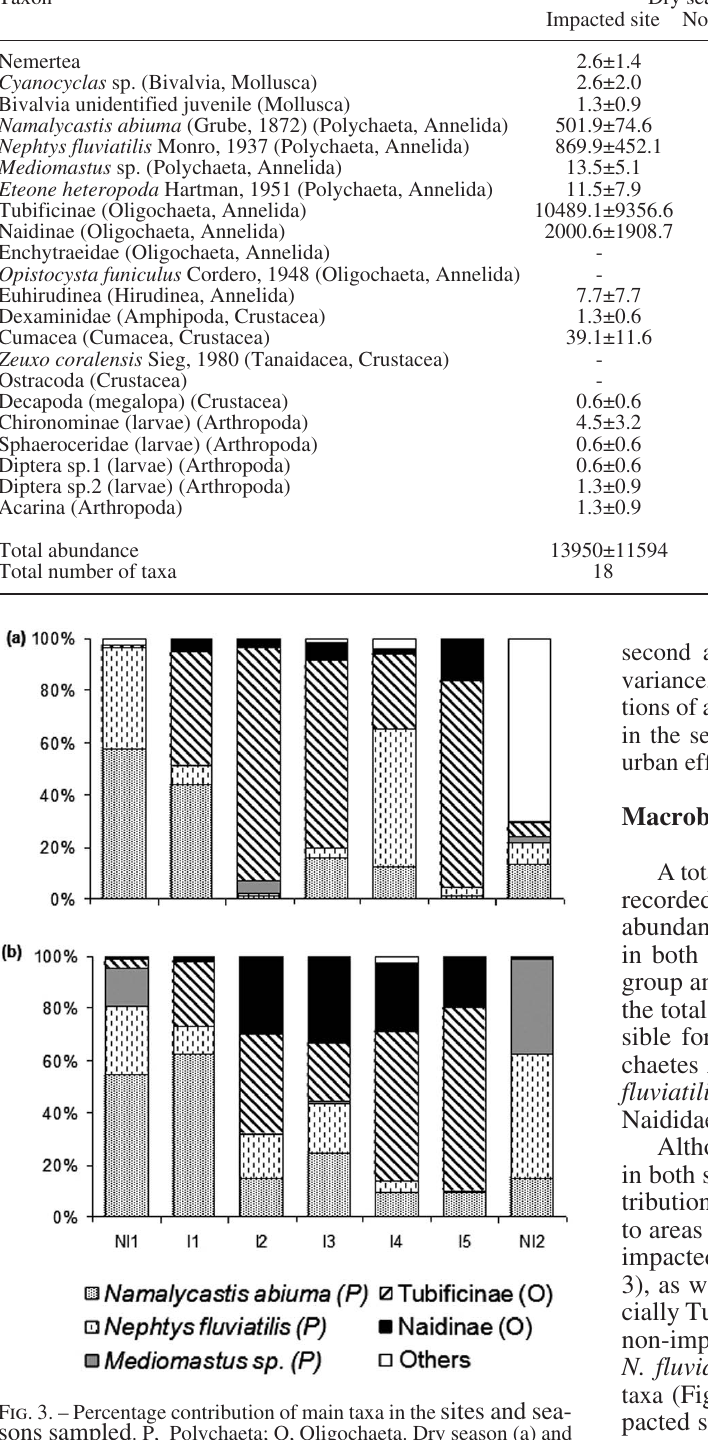
Table 3. – List of taxa (mean density±SE) for the benthic macrofauna in the Guajará Estuary. Taxon